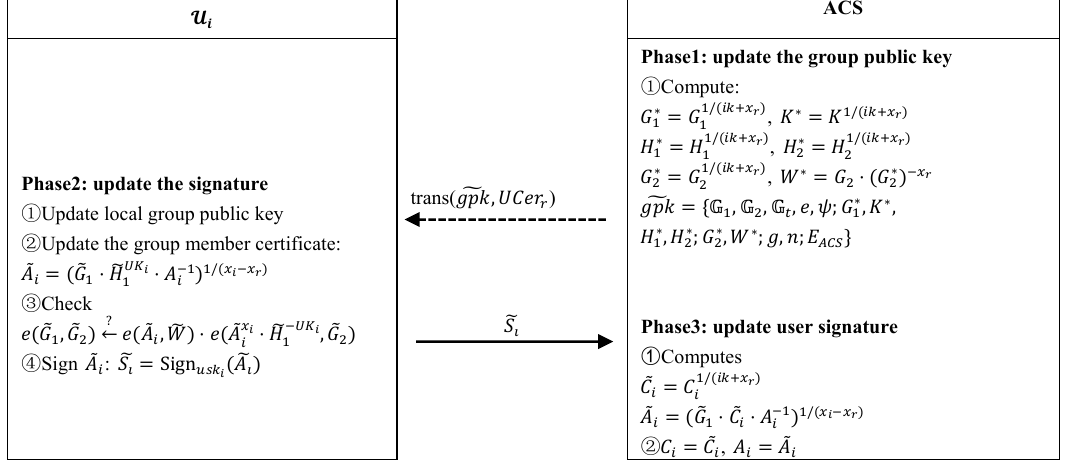
Figure 4. User revocation procedure.